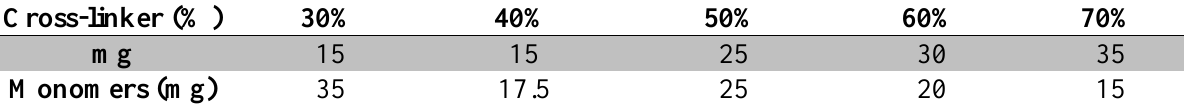
Table 1. Polymer compositions with different amount of cross linker.